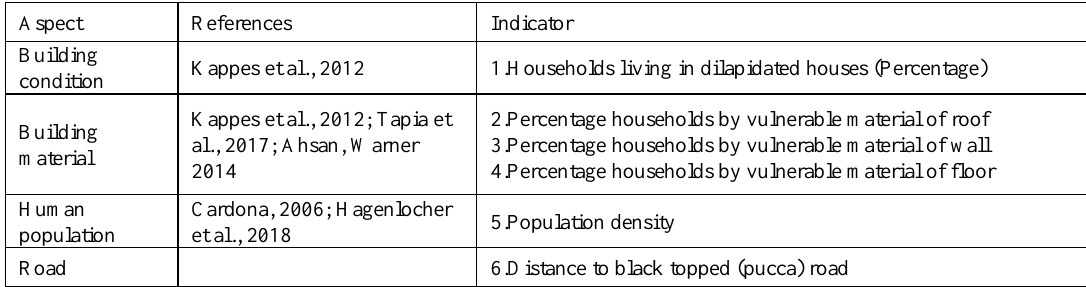
Table 1. Sub-dimensions, indicators and references for physical vulnerability.